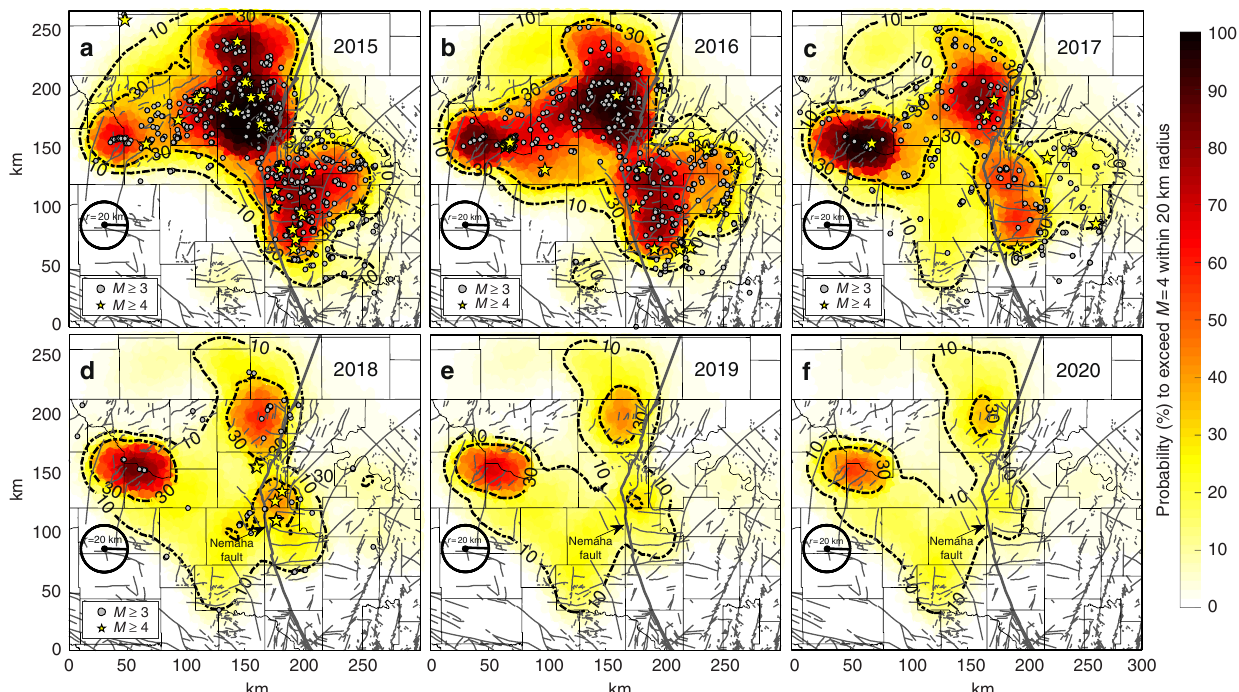
Fig. 3 Physics-based 1-year magnitude ( M ≥ 4) exceedance probability forecasts (2015 – 2020). Exceedance probabilities are forecasted in areas of 1257 km 2 (20-km radius) and for the time of 1 year. Grey circles and yellow stars show M ≥ 3 and M ≥ 4 earthquakes observed in the year of the forecast, respectively. The local seismic hazard is controlled by local pressure increase at depth and the local seismogenic state (the SI Fig. 2b – e). Decrease of magnitude probabilities from 2015 to 2020 is driven by reduced injection rates, which slow down the pressure increase at seismogenic depth. The strongest decrease of the seismic hazard is predicted east of the Nemaha fault, where injection rates were reduced most signi fi cantly. Probabilities of 2018 – 2020 were computed assuming constant injection rates after March 2018. The maps can be produced for arbitrary future injection scenarios